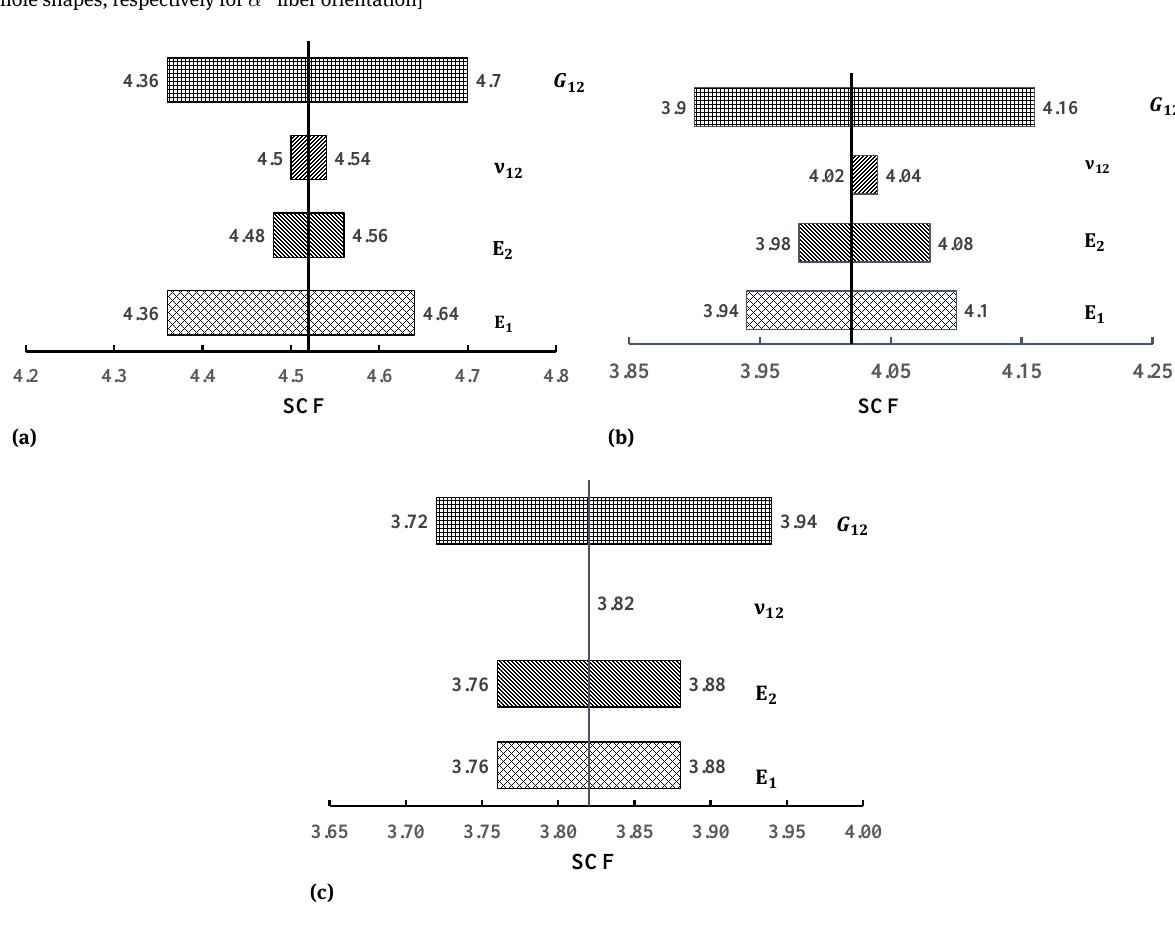
Figure 17: Tornado diagrams of SCF for a circular hole of size: (a) 0.015 m, (b) 0.0225 m, and (b) 0.030